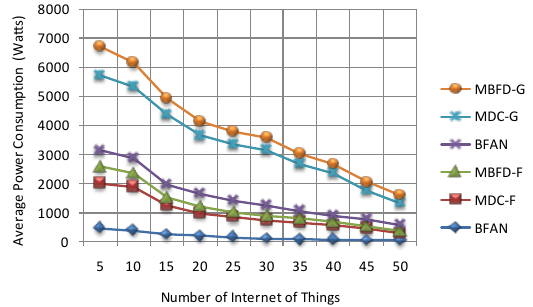
Figure 4. Average power consumption.